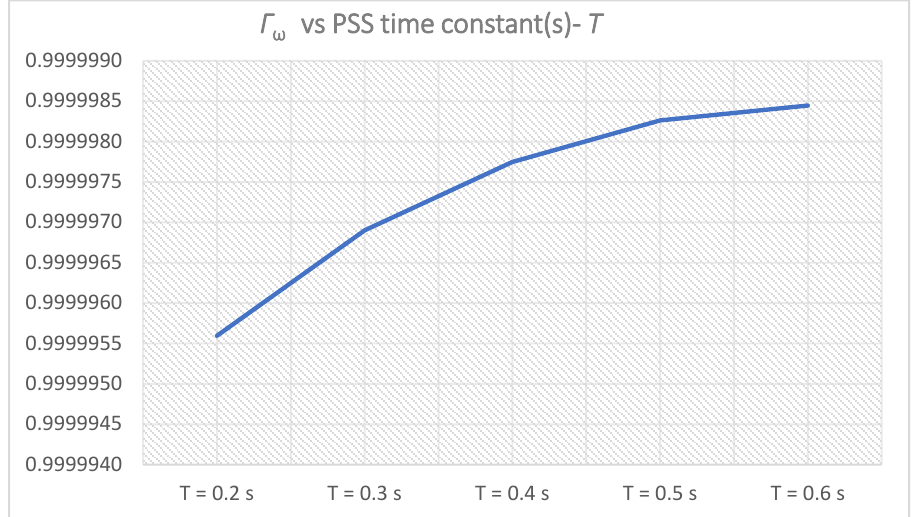
Figure 10. Γ ζi for PSS parameters K = 10, T = T i, 1 = 0.2 – 0.6 s.